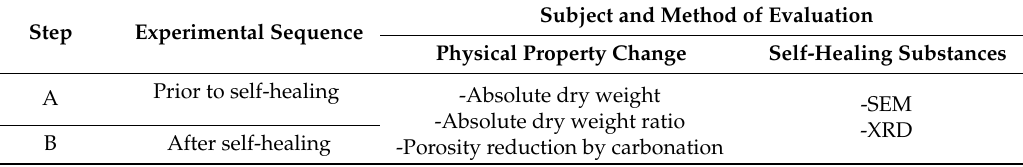
Table 2. Experimental procedure and evaluation.